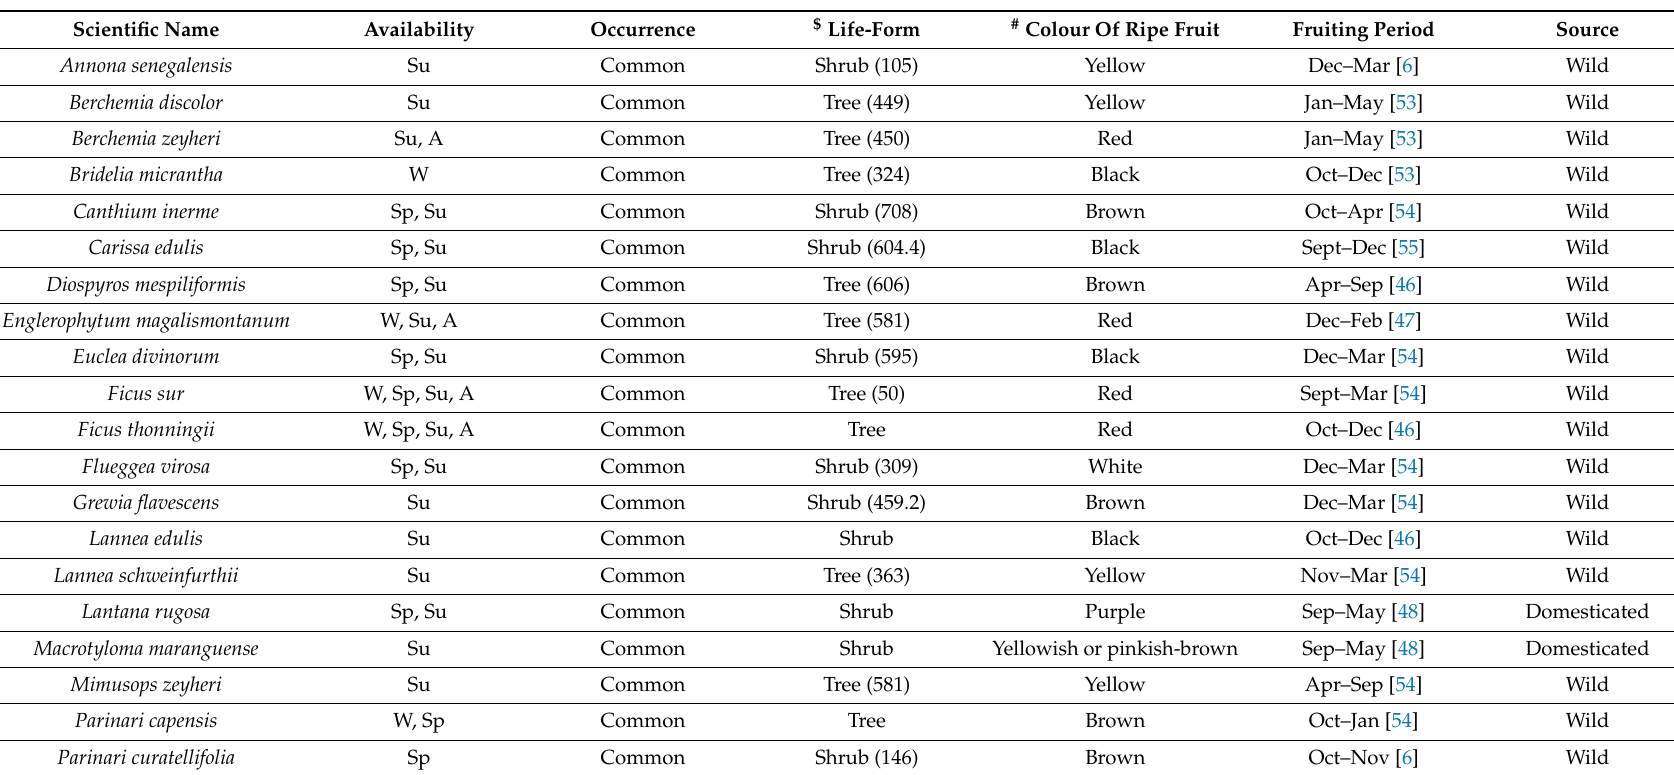
Table 3. Seasonal availability (W = winter, Sp = spring, Su = summer, A = autumn), occurrence, and ecological traits of fruit species in three villages in Bushbuckridge Local Municipality, Mpumalanga province, South Africa. SATN = South Africa. $ Life-form number provided in bracket is based on National List of Indigenous